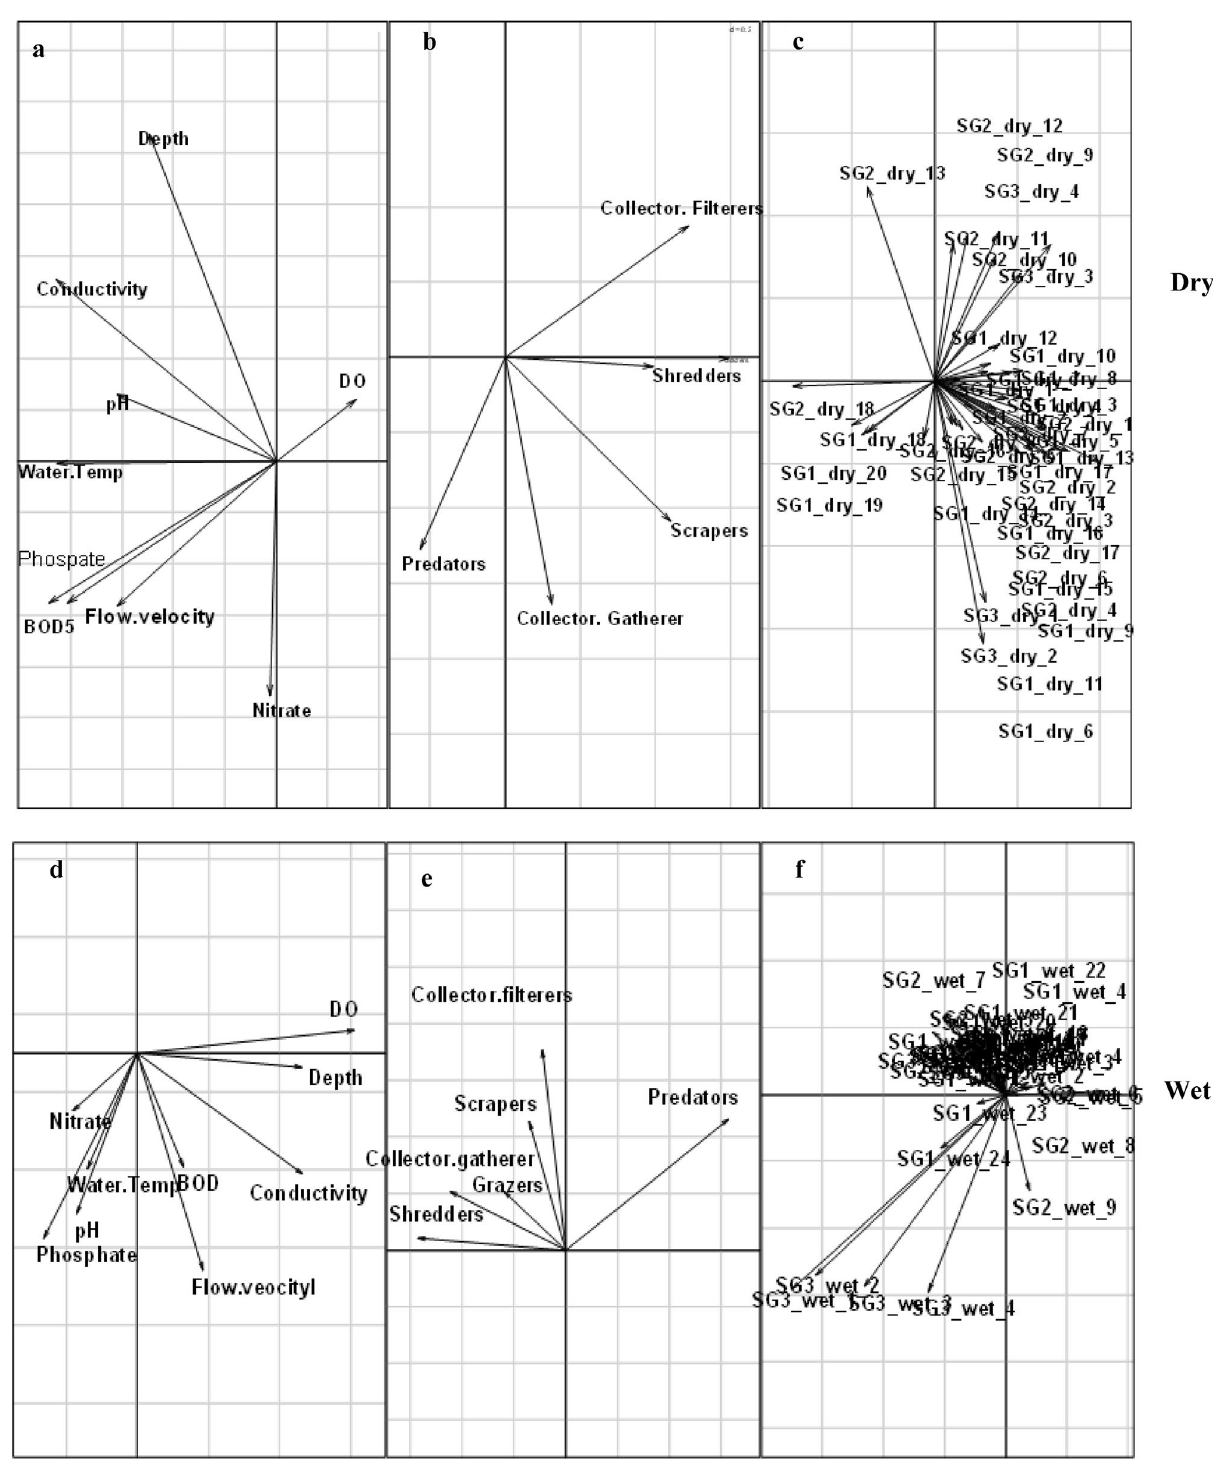
Figure 4. RLQ analysis showing the site grouping during the study period based on the analysed physicochemical variables ( a , d ), and the distribution of FFG ( b , e ) in relation to the sampling sites ( c , f ) in three station categories three site categories: Site group 1 (Site 1 = Adofi, Site 2 = Oleri, and Site 3 = Anwai upstream, Site 4 = Anwai downstream and Site 9 = Ogba upstream site), SG2: Site group 2 (Site 5 = Ethiope upstream, Site 6 = Ethiope downstream, Site 7 = Obosh and Site 8 = Ogba downstream) > SG3: Site group 3 (Site 10 = Orogodo and Site 11 = Warri